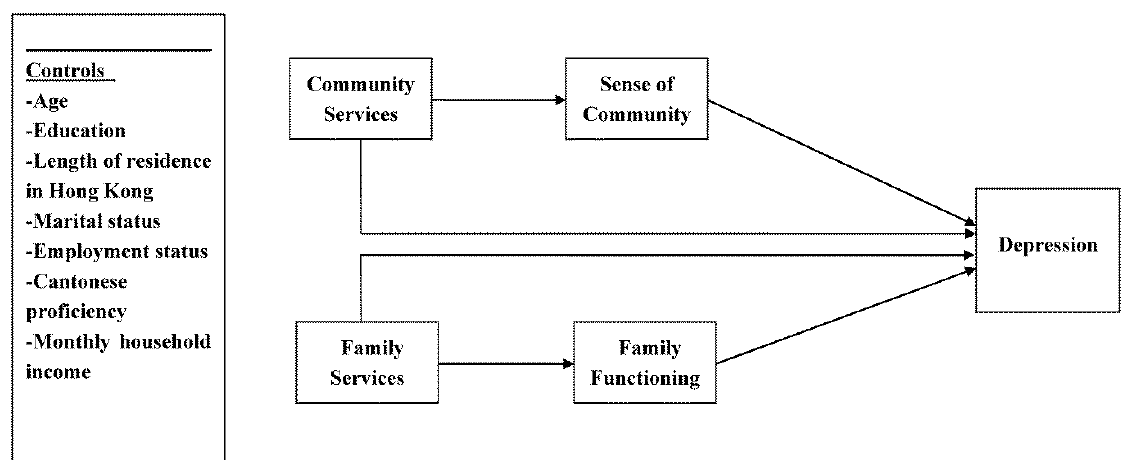
Figure 1. Hypothesized model of social service utilization, family functioning, sense of community and